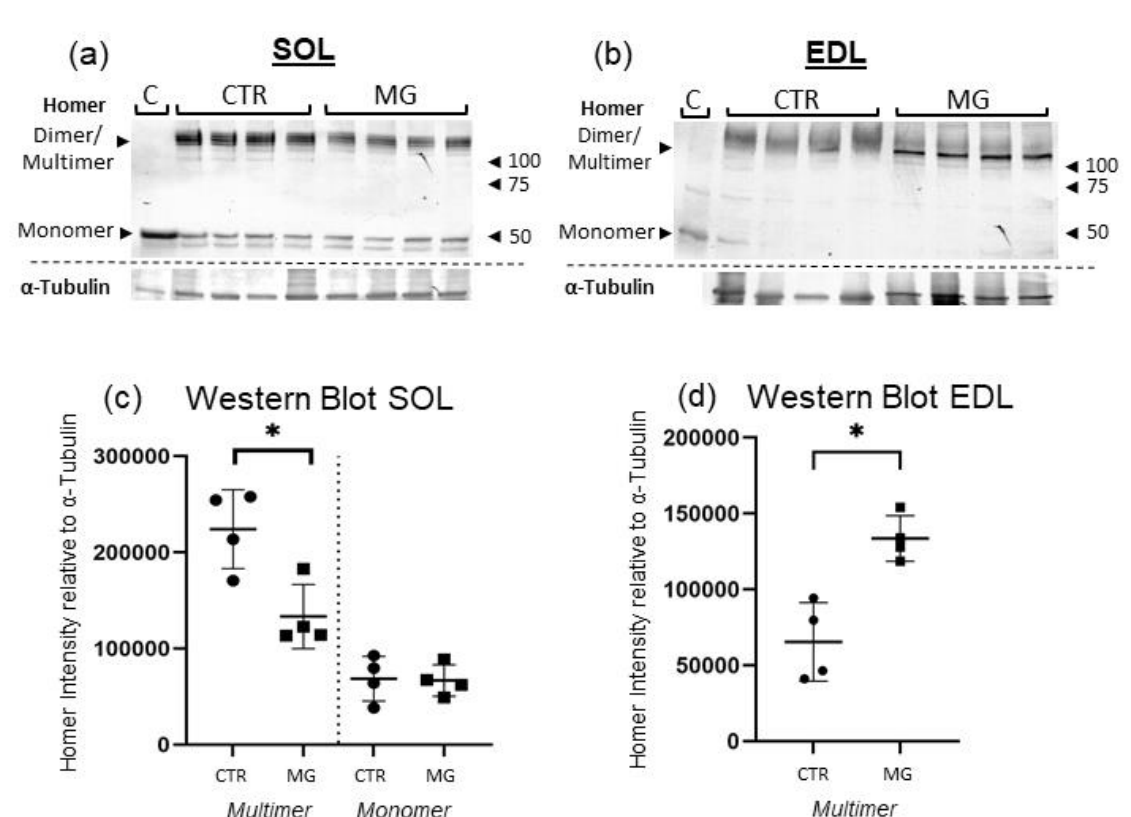
Figure 8. Homer Western Blot analysis of SOL and EDL . ( a ) WB total protein concentration of Homer in SOL . Band between 150 and 100 kDa represents Homer Dimers. Significant decrease of Dimer band intensity in SOL ( − 53.76%, p ≤ 0.0286) in native experimental conditions. ( b ) WB total protein concentration of Homer in EDL . In EDL , Homer 120 kDa band intensity is significantly increased (+146.25%, p ≤ 0.029) in EAMG compared to CTR. 42 kDa band, representing monomers, could not be detected in EDL , most likely due to relatively low expression of monomers in relation to Dimers. ( c ) WB of SOL . Dimers/Multimers between 150 and 100 kDa, Monomers (43–48 kDa) below 50 kDa. CTR samples 1–4 on the left, EAMG samples 1–4 on the right. α -Tubulin blot below was used for normalisation. ( d ) WB of EDL . All analysis was done in line with SOL Blot. Line C = Homer monomer positive control (murine cerebellum), n = 4 for CTR and EAMG. * indicates significant difference vs. CTR.